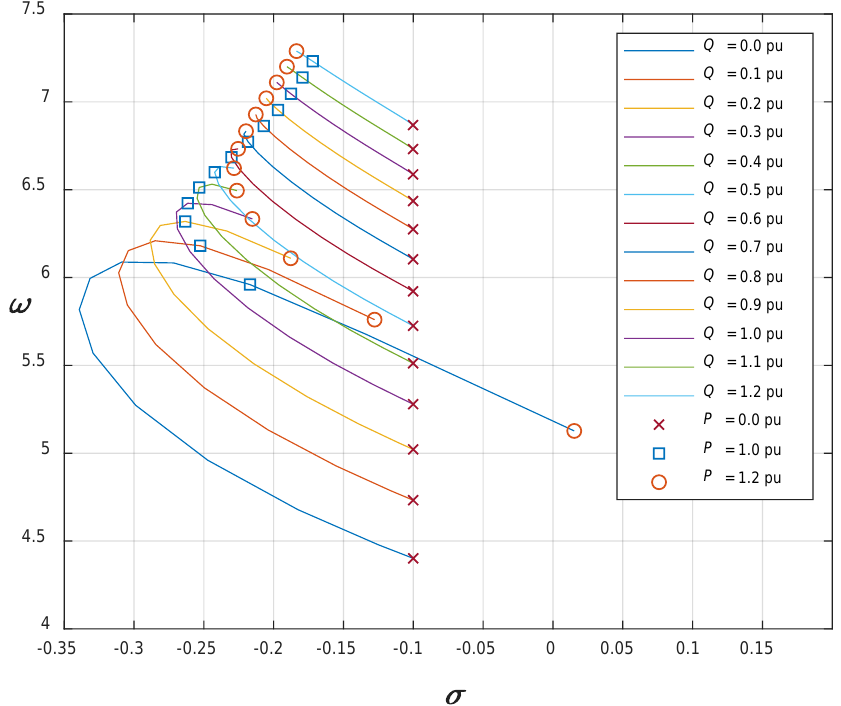
Figure 16. Eigenvalue loci of local mode of 25-MVA turbo-type synchronous generator with AVR. Again, the eigenvalue curves had a similar shape for all turbo-type synchronous generators of different powers equipped with an AVR system. It can be seen that the increase in active power can have a negative effect on damping or causes instability only at very small values of reactive power and at very large values of active power. In the remaining (larger) part of the operating range, changing the produced active and reactive power has a similar effect on local mode eigenvalues as that of turbo-type synchronous generators without